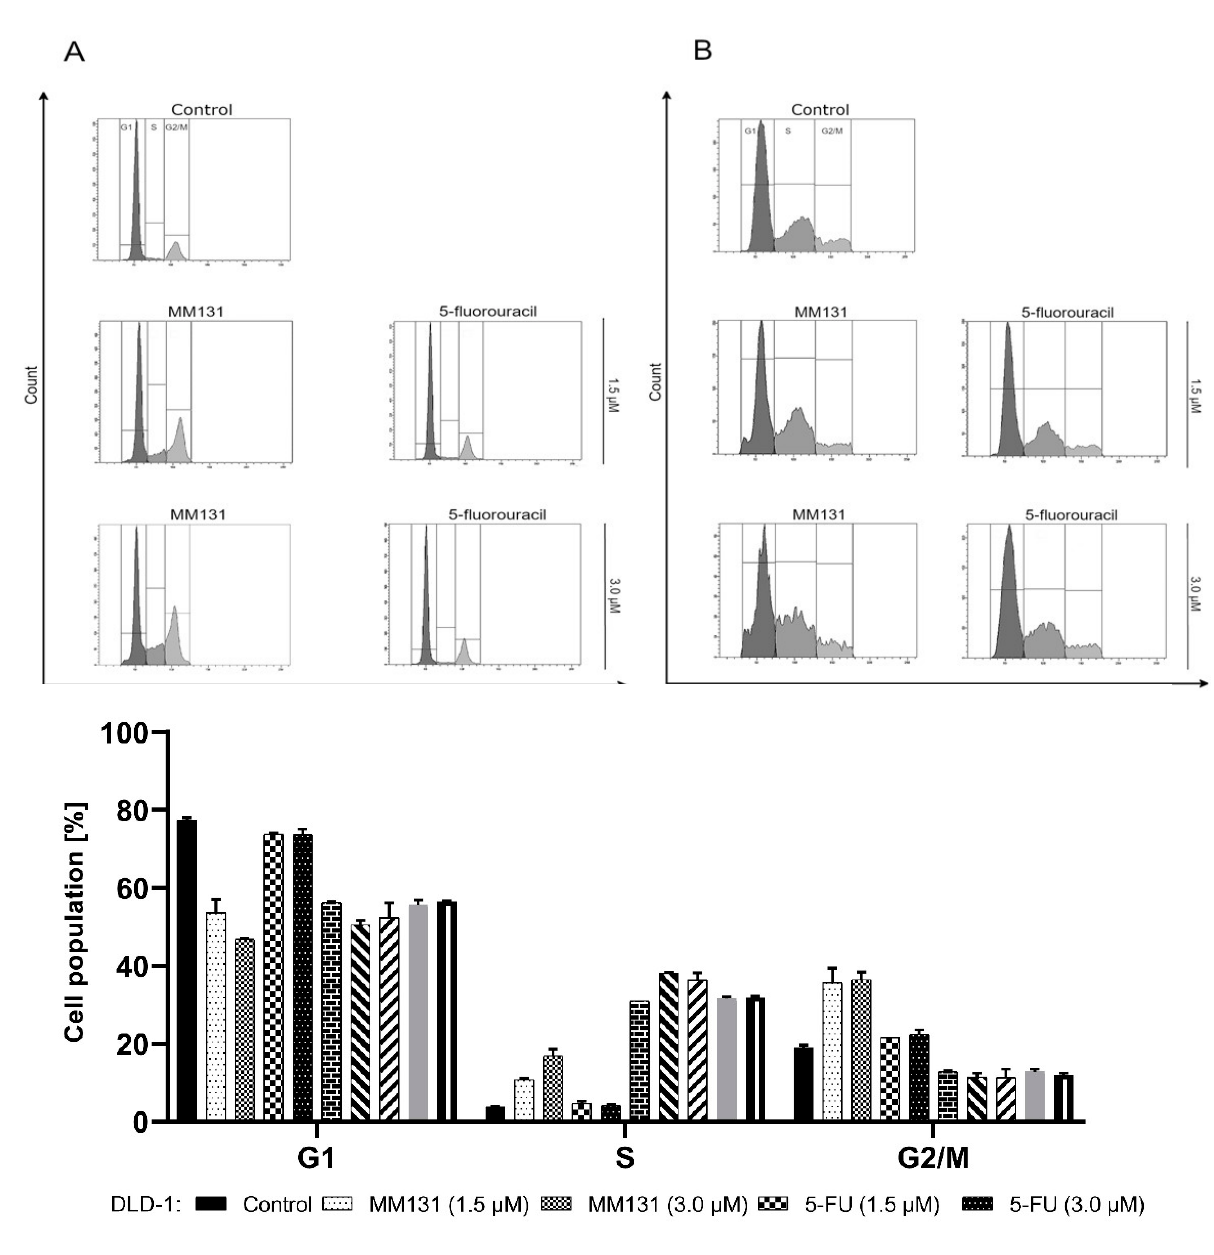
Figure 8. The influence of the tested compounds on cell cycle distribution in human colon DLD-1 ( A ) and HT-29 cells ( B ) after 24 h of incubation. Representative flow cytometry profiles depicting the cell cycle distribution and histograms representing the percentages of the cell population at each phase of the cell cycle are demonstrated. Mean ± SD from three independent experiments ( n = 3) done in duplicate are presented.